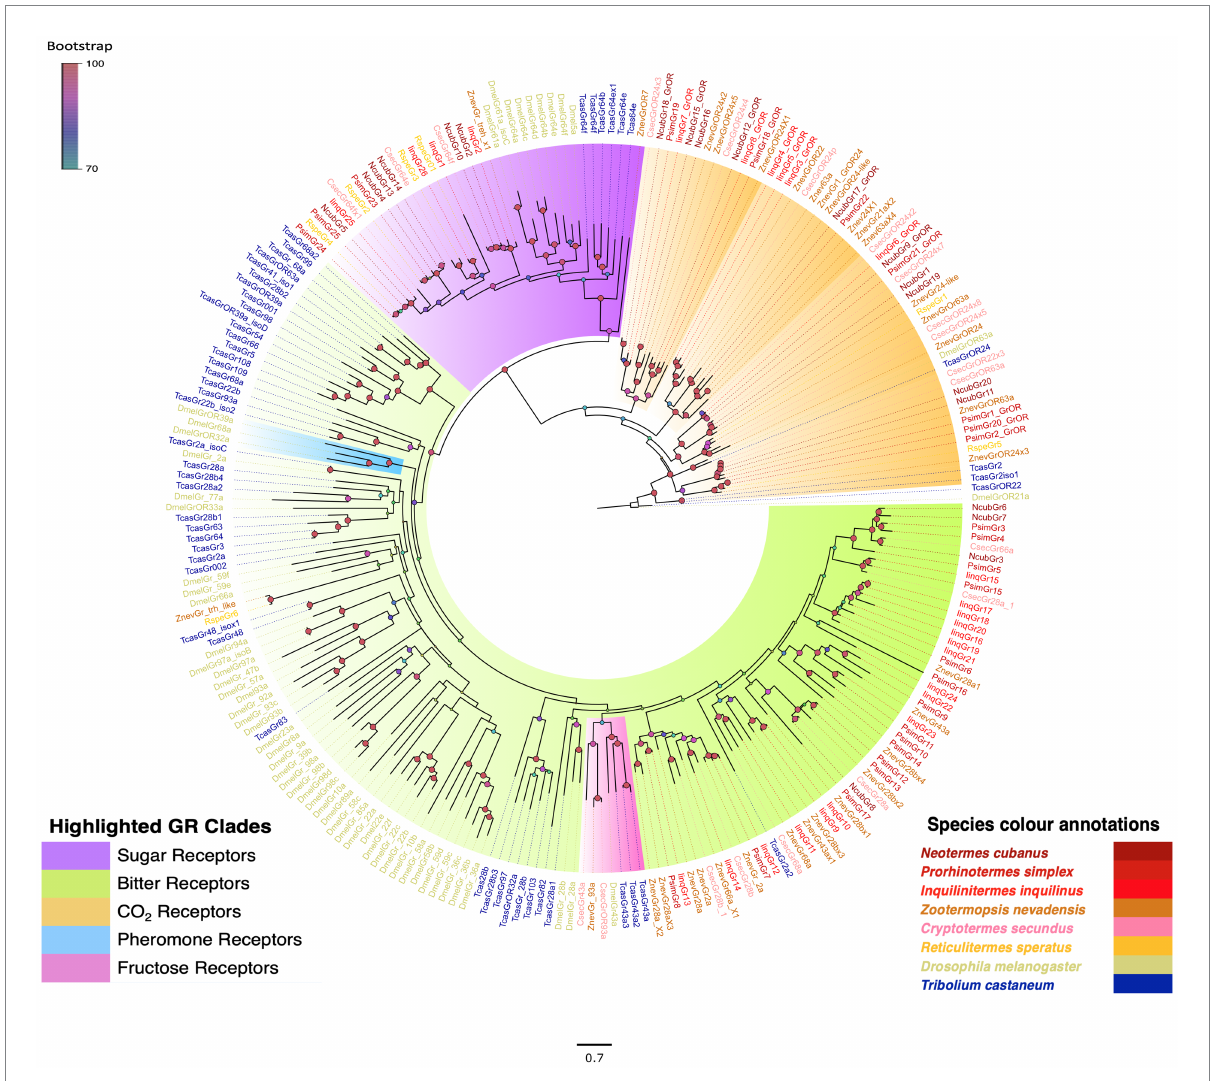
FIGURE 2 Maximum likelihood phylogeny of termite GRs highlighting known taste and CO 2 receptors. The highlighting details are provided in-figure legend. The tree was constructed using JTT + F + G4 as best-fit amino acid substitution model and rooted with CO 2 and sugar receptors as their basal location reported earlier in analyses with GRLs of other animals (Robertson, 2015; Robertson et al., 2018). Species included in the phylogeny are N. cubanus (Ncub), P. simplex (Psim), I. inquilinus (Iinq), Z. nevadensis (Znev) R. speratus (Rspe), C. secundus (Csec), T. castaneum (Tcas) and D. melanogaster (Dmel). Sequence names are colored according to species and color codes are provided in the in-figure legend. Node color indicates the bootstrap support value based on 1,000 replicates. The scale bar indicates the estimated amino acid substitutions per